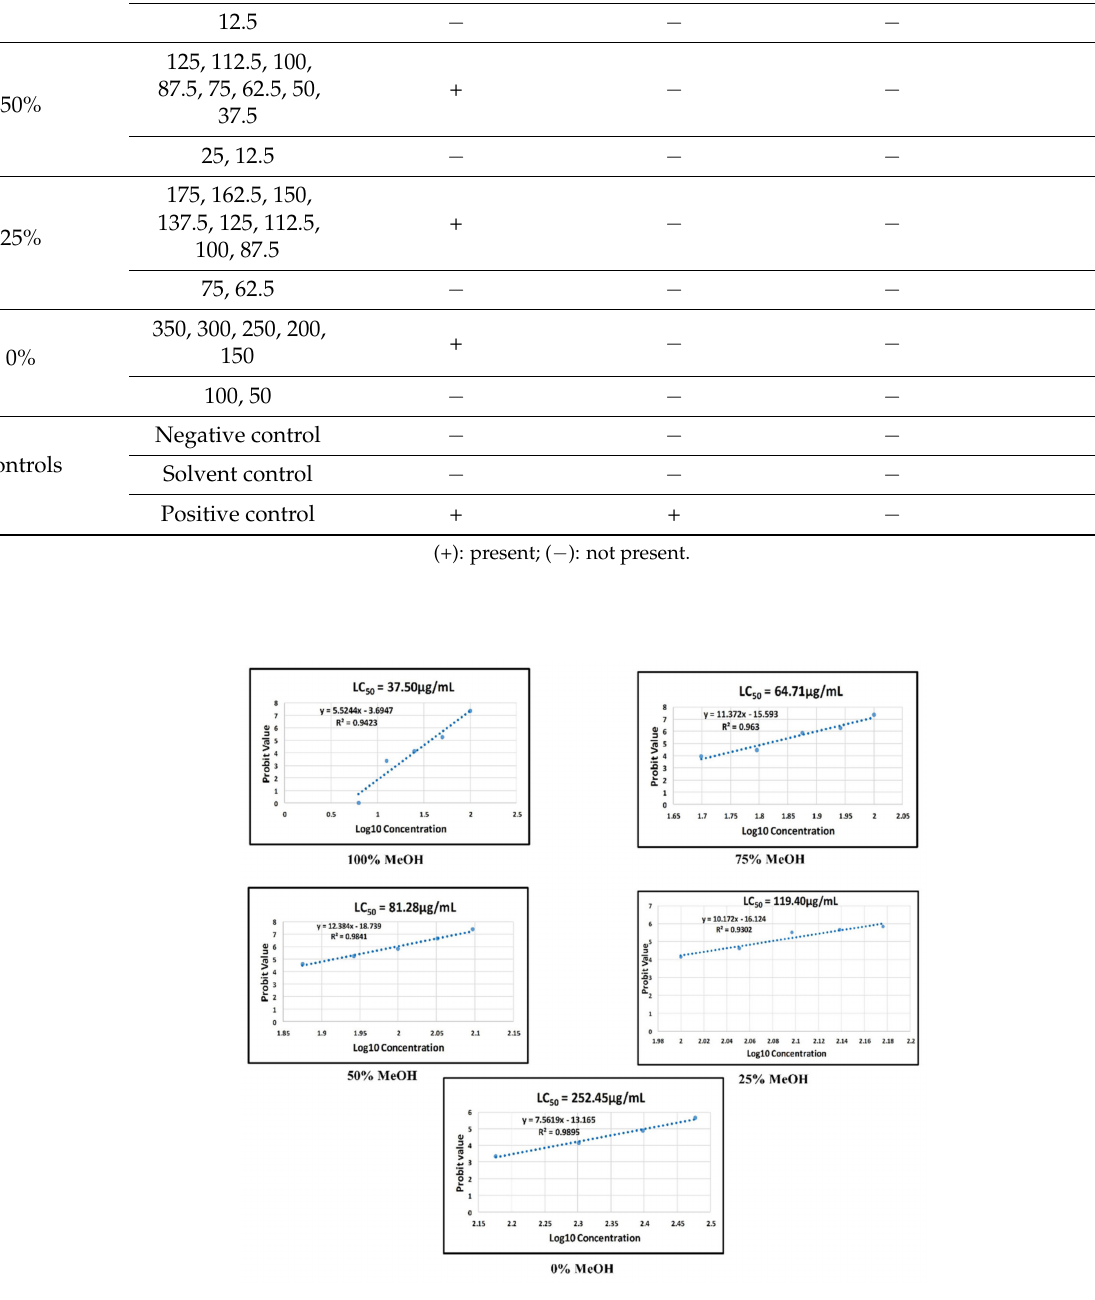
Figure 3. Logarithmic measurement of the LC 50 value of five P. malayana leaf extracts (0, 25, 50, 75, and 100% v/v methanol-water) using probit